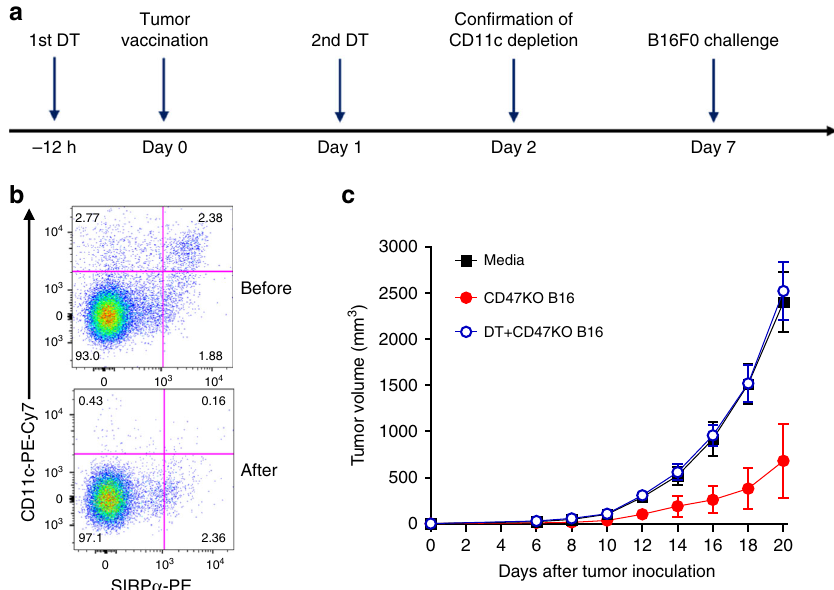
Fig. 7 Role of CD11c + DCs in antitumor effects of tumor cell vaccination. a Schematic outline of the experimental design. b Flow cytometry pro fi les showing deletion of CD11c + DCs in DT-injected mice (analysed 1 day after the last DT injection). c Tumor growth in CD11c-DTR → B6 BM chimeras that were vaccinated with media, or with irradiated CD47KO B16F0 with or without DT treatment ( n = 5 per group), followed 7 days later by subcutaneous injection of 2 × 10 5 WT B16F0 melanoma cells. Tumor growth is shown as tumor volumes (mean ± SEM) over time. Source data are provided as a Source Data fi le.